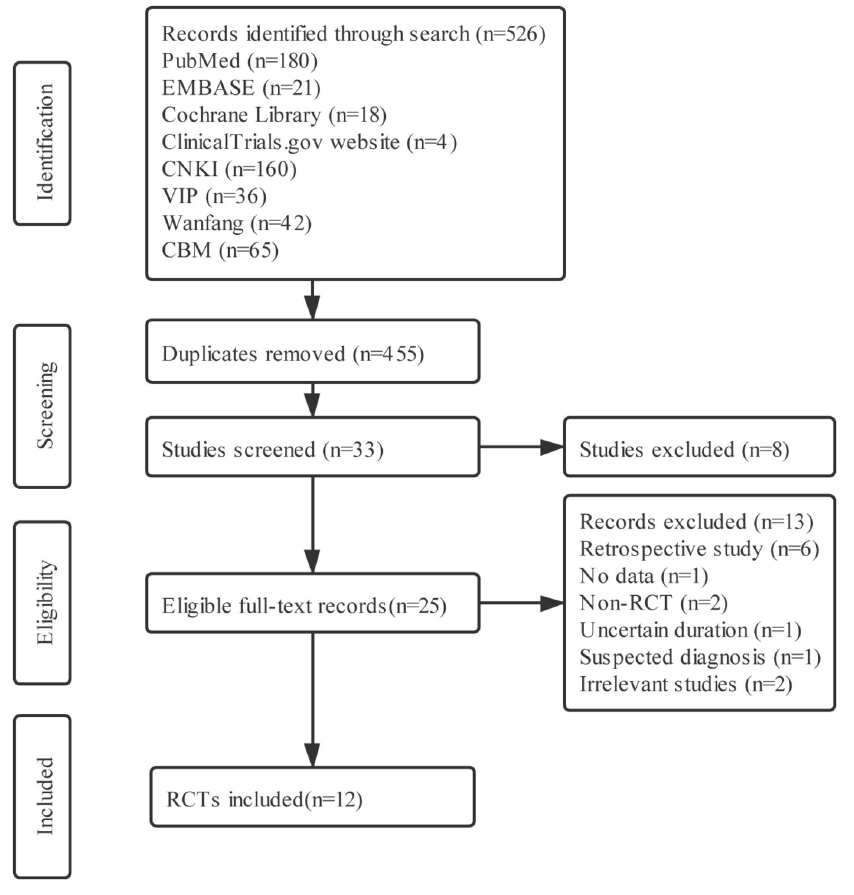
Fig 1. The flow diagram of study selection and